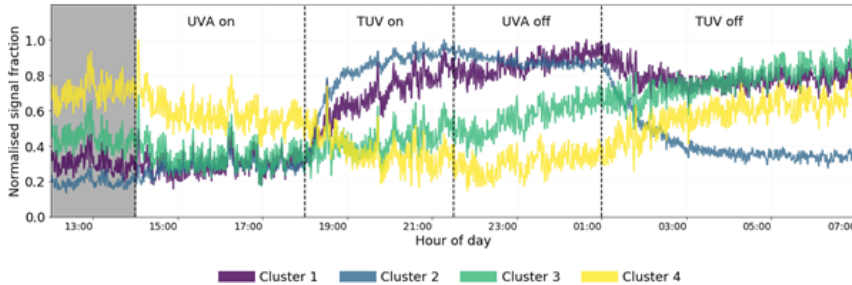
Figure 12. Time series of the four cluster means for the high-NO x experiment. Clusters 3 and 4 represent slow-formation and background clusters and give no information regarding the effect of NO 2 photolysis. Clusters 1 and 2 display similar behaviours when the TUV light is switched on but different behaviours when the UVA light is switched off, indicating their members are sensitive to the change of the NO / NO x ratio determined by the UVA light state. The shaded area is the dark state before any photolysis occurs.